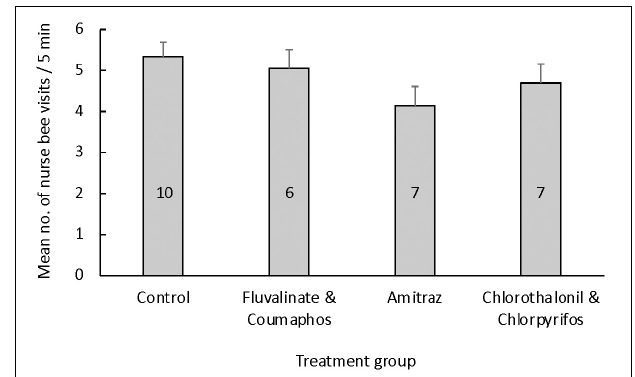
FIGURE 1 | Mean ( ± S.E.M.) number of nurse feeding events per queen larva during 5-min intervals based on the queen’s rearing environment. Queen larvae were reared in cups coated with molten wax that was either pesticide-free (control group) or contaminated with field-relevant concentrations of either (a) a combination of tau -fluvalinate and coumaphos, (b) amitraz alone, or (c) a combination of chlorothalonil and chlorpyrifos. The number of queens used per treatment group is given inside each bar. There were no differences in the nurse feeding rate toward queen larvae based on the treatment group [ANOVA: F ( 3 , 29 ) = 1.41, p = 0.26].